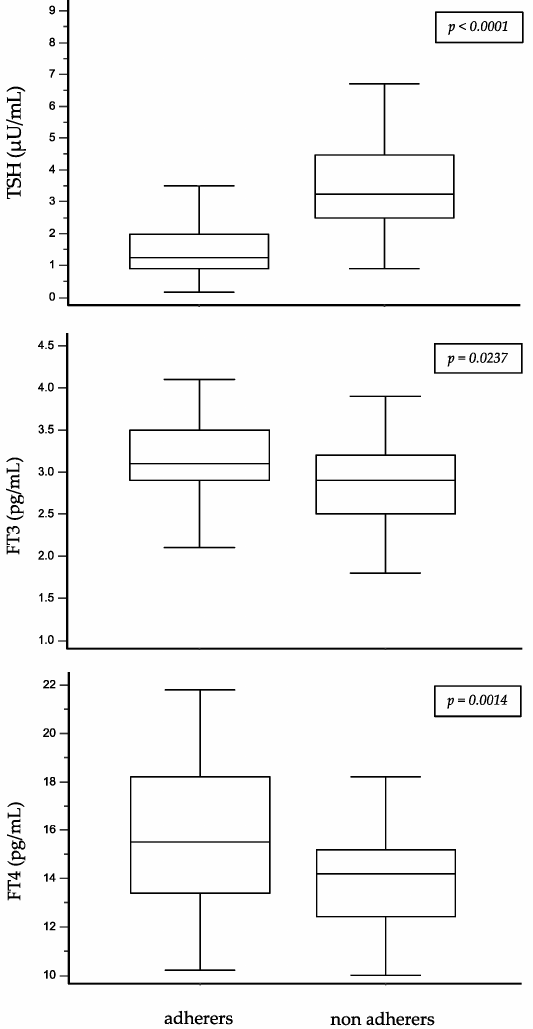
Figure 1. Circulating levels of TSH, FT3 and FT4 in adherers and non-adherers to L-T4 replacement therapy (Wilcoxon Rank Sum